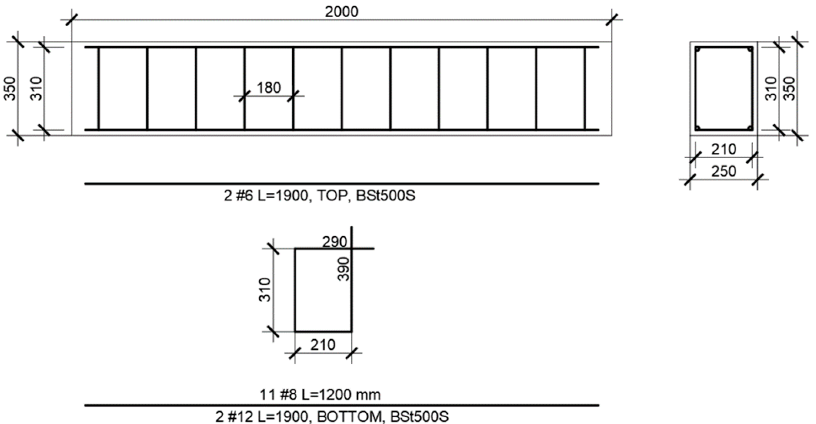
Figure 2. Reinforcement bars for the beams.